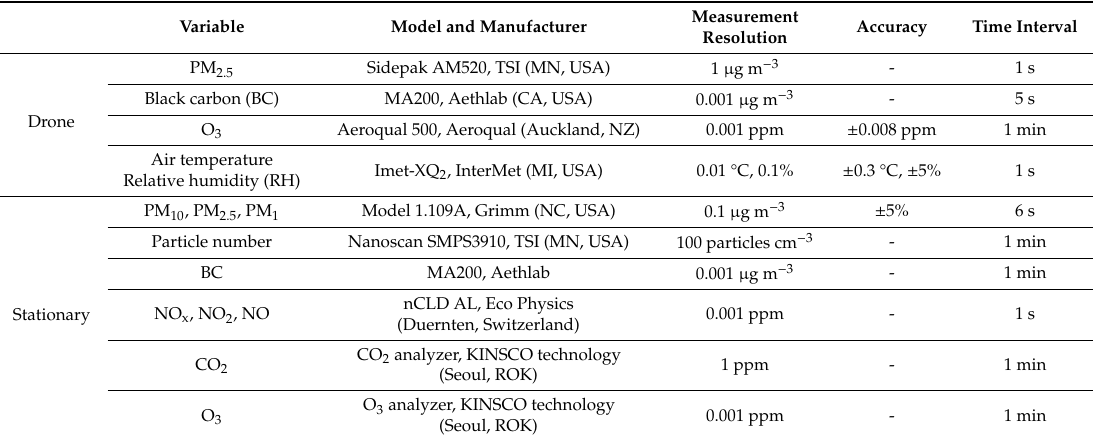
Table 1. Specifications of instruments used for drone and stationary